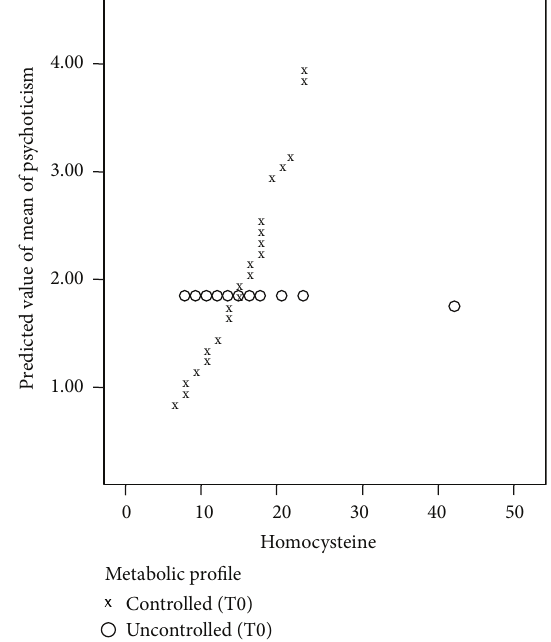
Figure 1: Predicted values of mean of psychoticism by homocys- teine levels and diabetes profile.